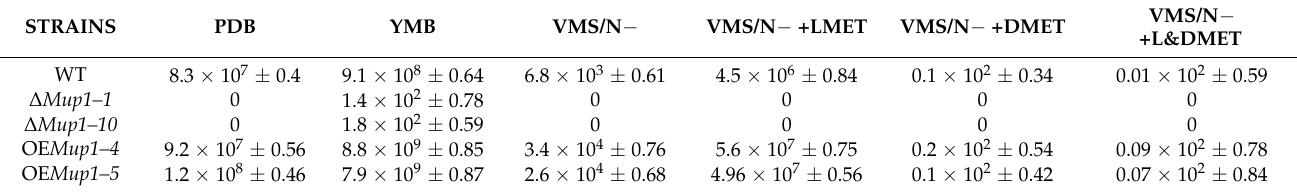
Table 3. Chlamdydospore production of WT and mutants on different liquid